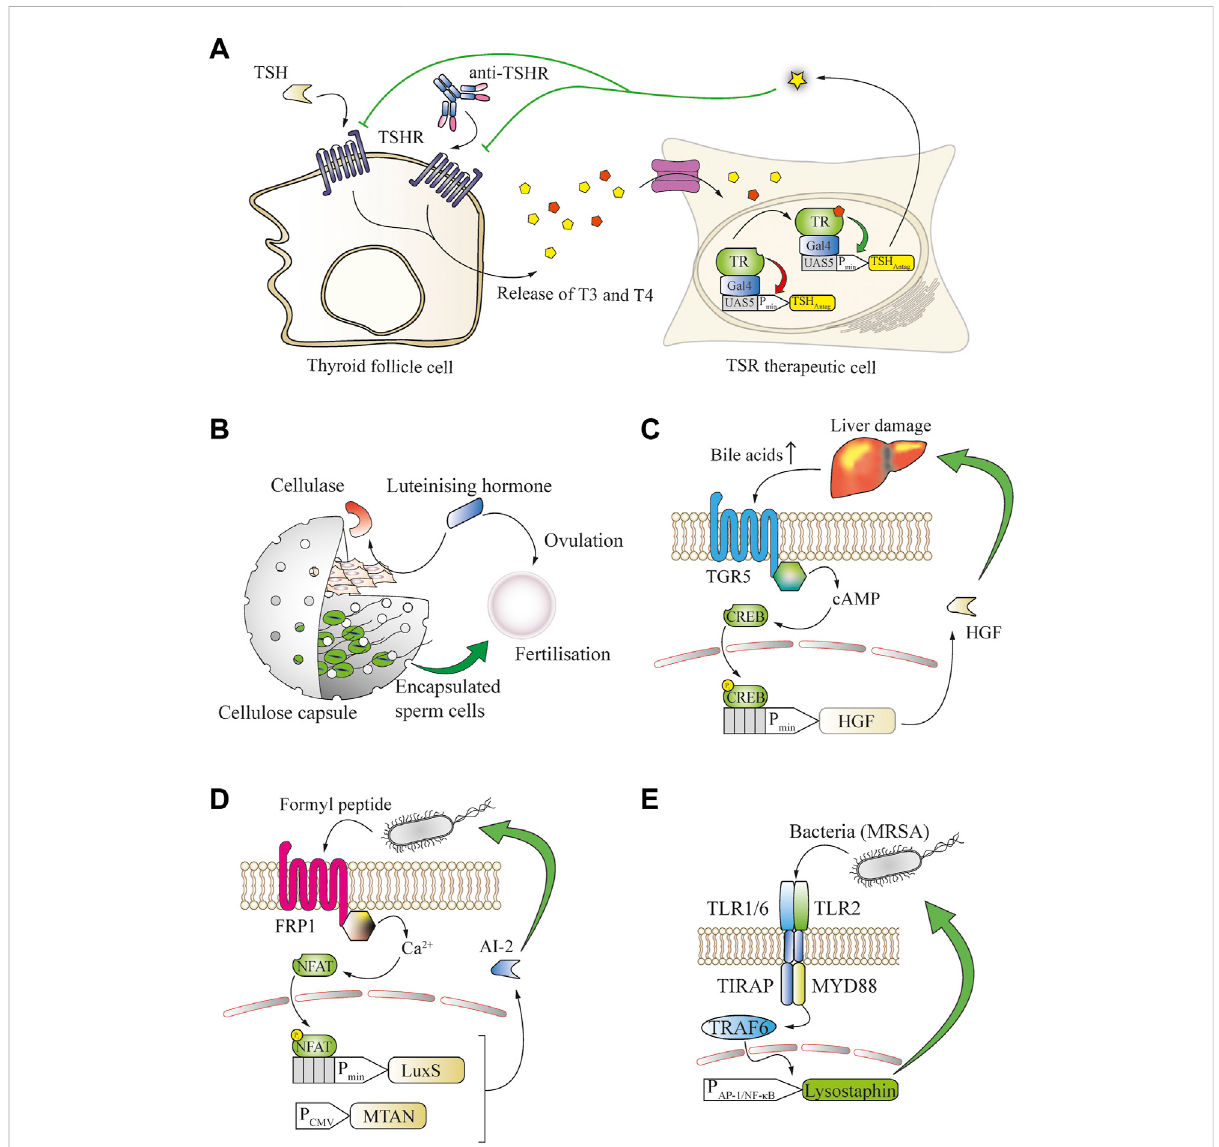
FIGURE 4 Manysmallmoleculescanbeusedasbiomarkerstoenableclosed-looptherapeuticcircuitsinengineeredmammaliancells. (A) Graves ’ disease can be treated in a closed loop by T3/T4-responsive production of a thyroid-stimulating hormone receptor (TSHR) antagonist. Thyroid follicle cells release increased amounts of the thyroid T3 and T4 hormones upon overstimulation by TSH or antibodies targeting the TSH receptor. The released thyroid hormones bind to an engineered fusion protein of the thyroid receptor to a Gal4 DNA-binding domain and activate the expression of a TSH antagonist from a chimeric promoter, which potently blocks the overactivation of TSH receptors. (B) Bovine fertilization in vivo is enabled through closed-loop control of the in utero release of sperm cells by the ovulation-triggering luteinizing hormone. LH induces the expression of cellulasebyco-encapsulatedengineeredcells,resultingindegradationofthecapsuleandreleaseofthespermcells. (C) Bileacidserumlevelsarean indicator of liver damage and can enable closed-loop hepatocyte protection. An increase in serum concentration of bile acids activates the TGR5 GPCR expressed by engineered cells, which converges into the intracellular cAMP cascade to trigger the expression of hepatocyte growth factor (HGF) from a CREB-operated promoter, limiting the liver damage. (D) N-Formyl peptide, a typical bacterial signature biomarker, enables closed-loop release of quorum-sensing interference molecules from engineered mammalian cells. Upon binding of the biomarker to the FRP1 GPCR, an intracellular calcium in fl ux is triggered that activates the NFAT transcription factor and induces expression of the S-ribosylhomocysteinelyaseLuxS,which,togetherwiththeconstitutivelyexpressedMTAN,enablestheproductionofthe Pseudomonasaeruginosa quorum-sensingsignal moleculeAI-2. (E) Bacterialcell-wall componentscanserve asbiomarkersfor engineeredbactericidalcells. Thepresenceof bacteria, including methicillin-resistant S. aureus , is sensed by heterodimeric receptors formed by TLR2 and the TLR1 or TLR6 chains. These receptors activate TRAF6 via MYD88 and enable inducible expression of the potent bactericidal peptide lysostaphin from a minimal AP-1 or NF- κ B promoter, leading to elimination of the